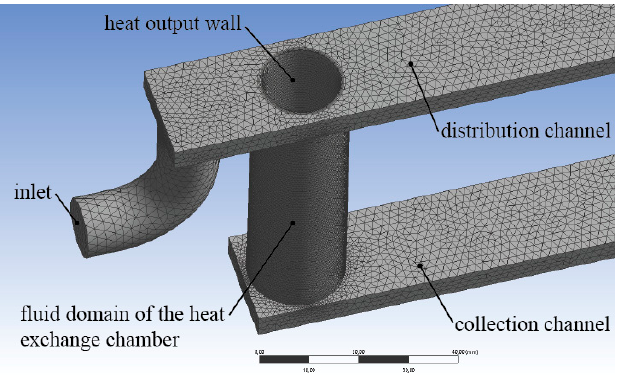
Figure 2. Partial view of the mesh for the basic shape of the proposed manifold header and partial depiction of the boundary conditions.